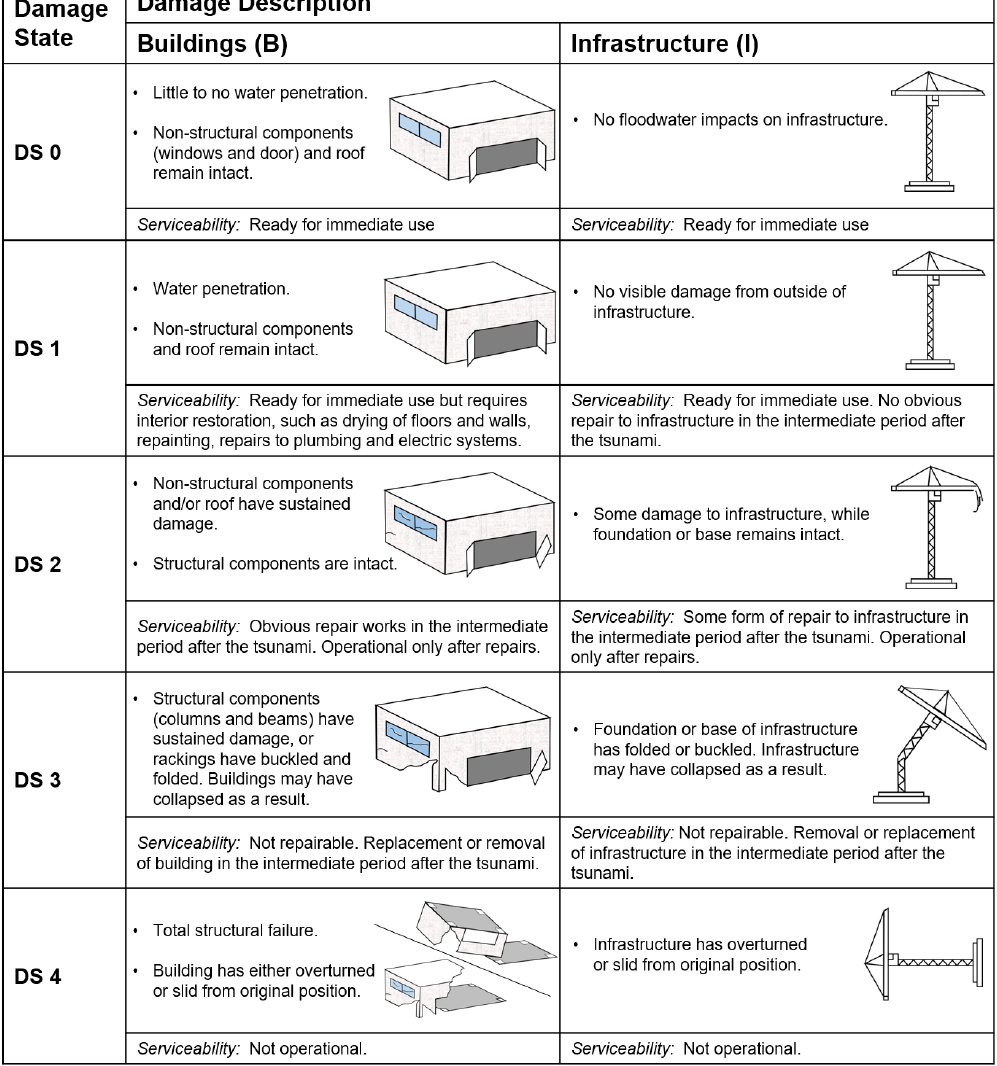
Figure 3. Proposed new damage classification for port industries. Descriptions for damage to both buildings and non-building infrastructure, together with simplified illustrations of the structures, are provided in the classification table. DS 1 and DS 2 are considered as non-structural damages, while DS 3 and DS 4 are structural